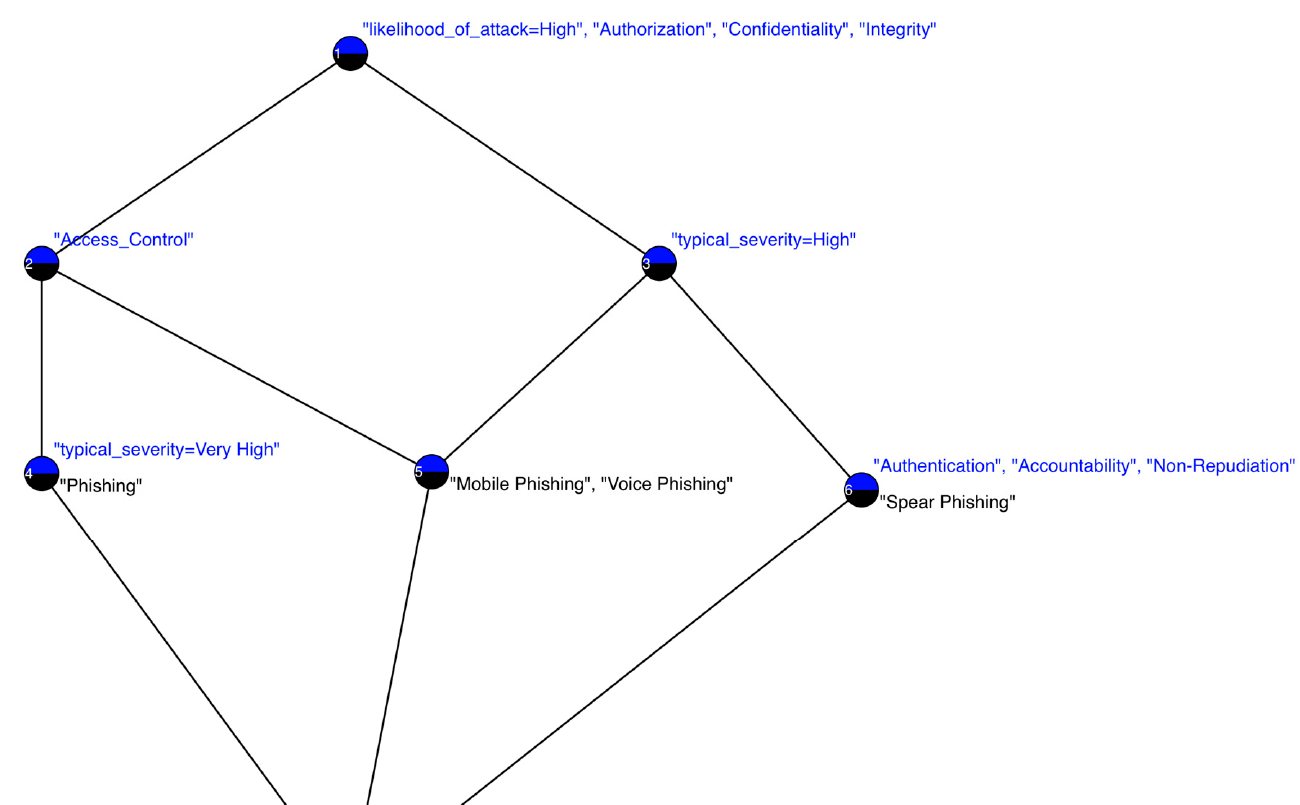
Figure 2. Fragment of a formal concept lattice for analysis of cyberattacks, taken from the CAPEC datatset and based on shared values for the attributes: “likelihood_of _attack”, “typical_severity” and “consequences” (shown in blue). Objects (attack types) are shown in black.